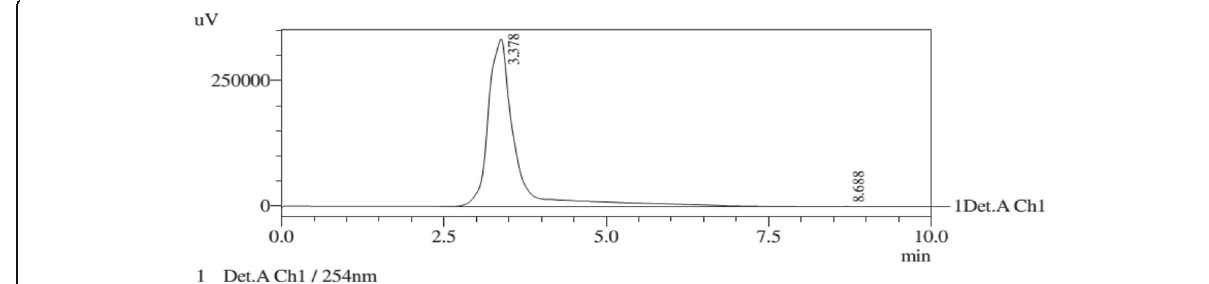
Fig. 7 RP-HPLC chromatogram of the Silkworm Sericin